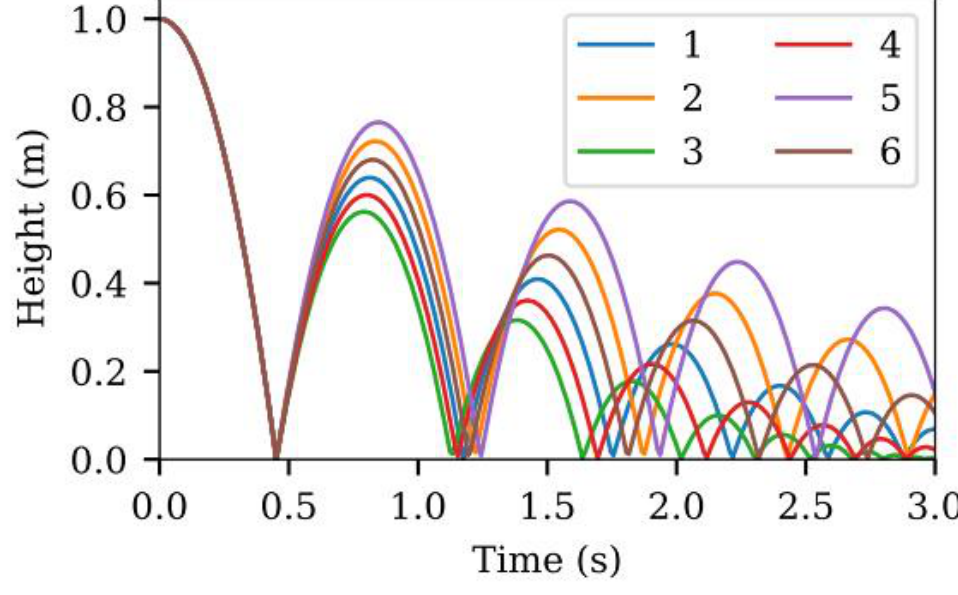
Figure 1. The first 6 trajectories of the training set when only the coefficient of restitution